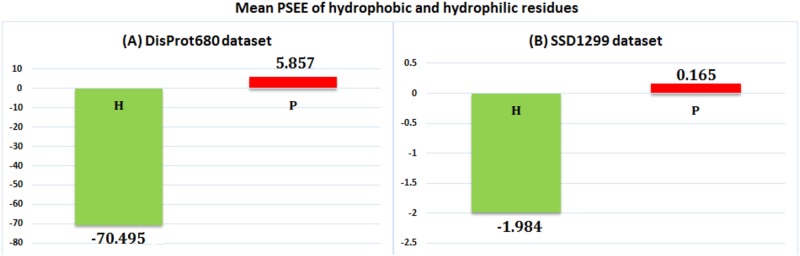
Mean PSEE of hydrophobic and hydrophilic residues.PSEE for hydrophobic (green bar) and hydrophilic (red bar) residues of (A) DisProt680 dataset and (B) SSD dataset. The bars are label with the respective mean PSEE values.